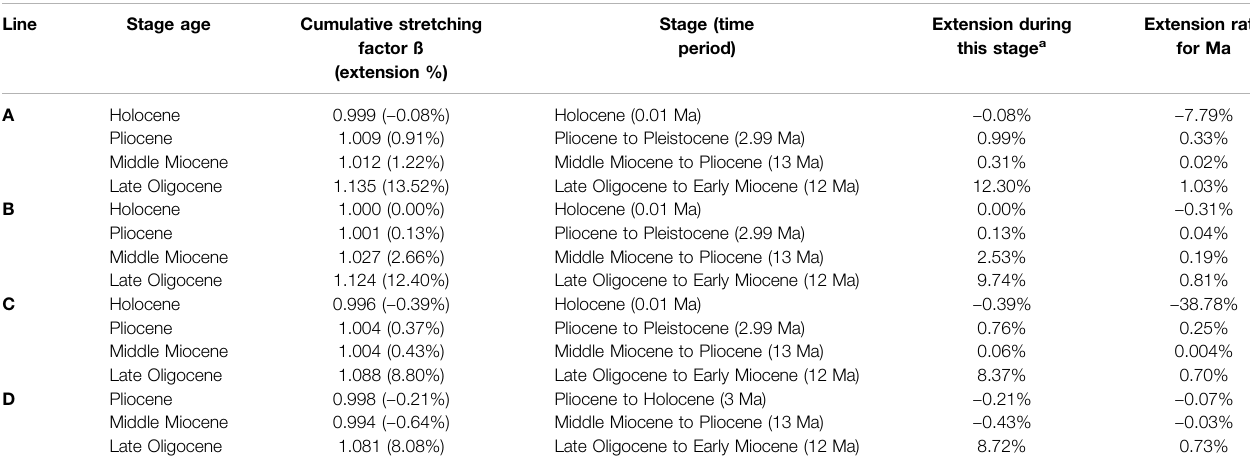
TABLE 3 | Calculation of extension for the evolutionary